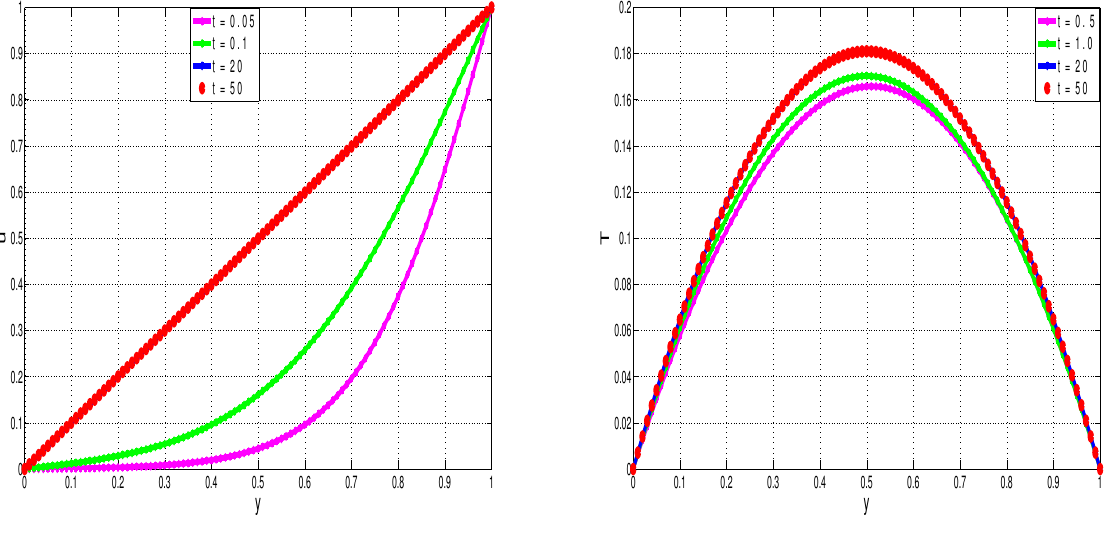
Figure 2. Development of steady velocity profiles ( left ) and temperature profiles ( right ) .